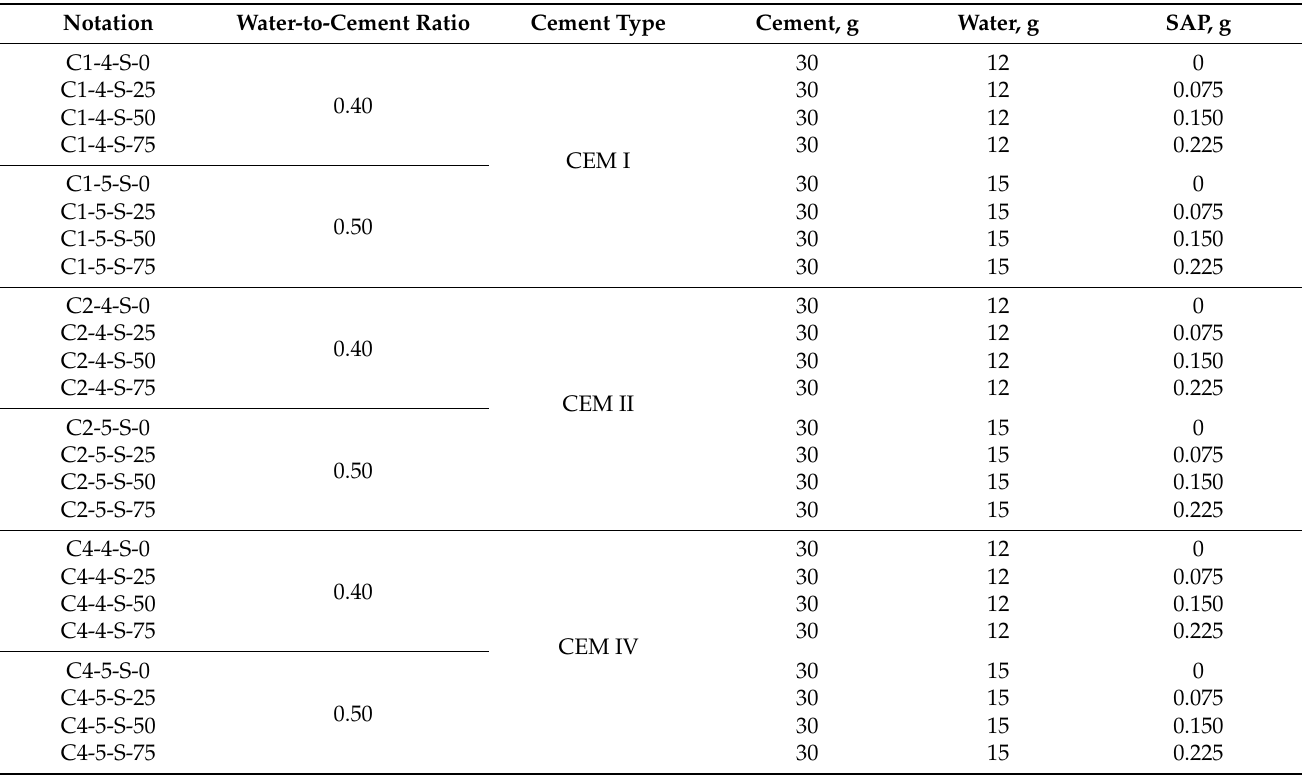
Table 2. Mix components for each